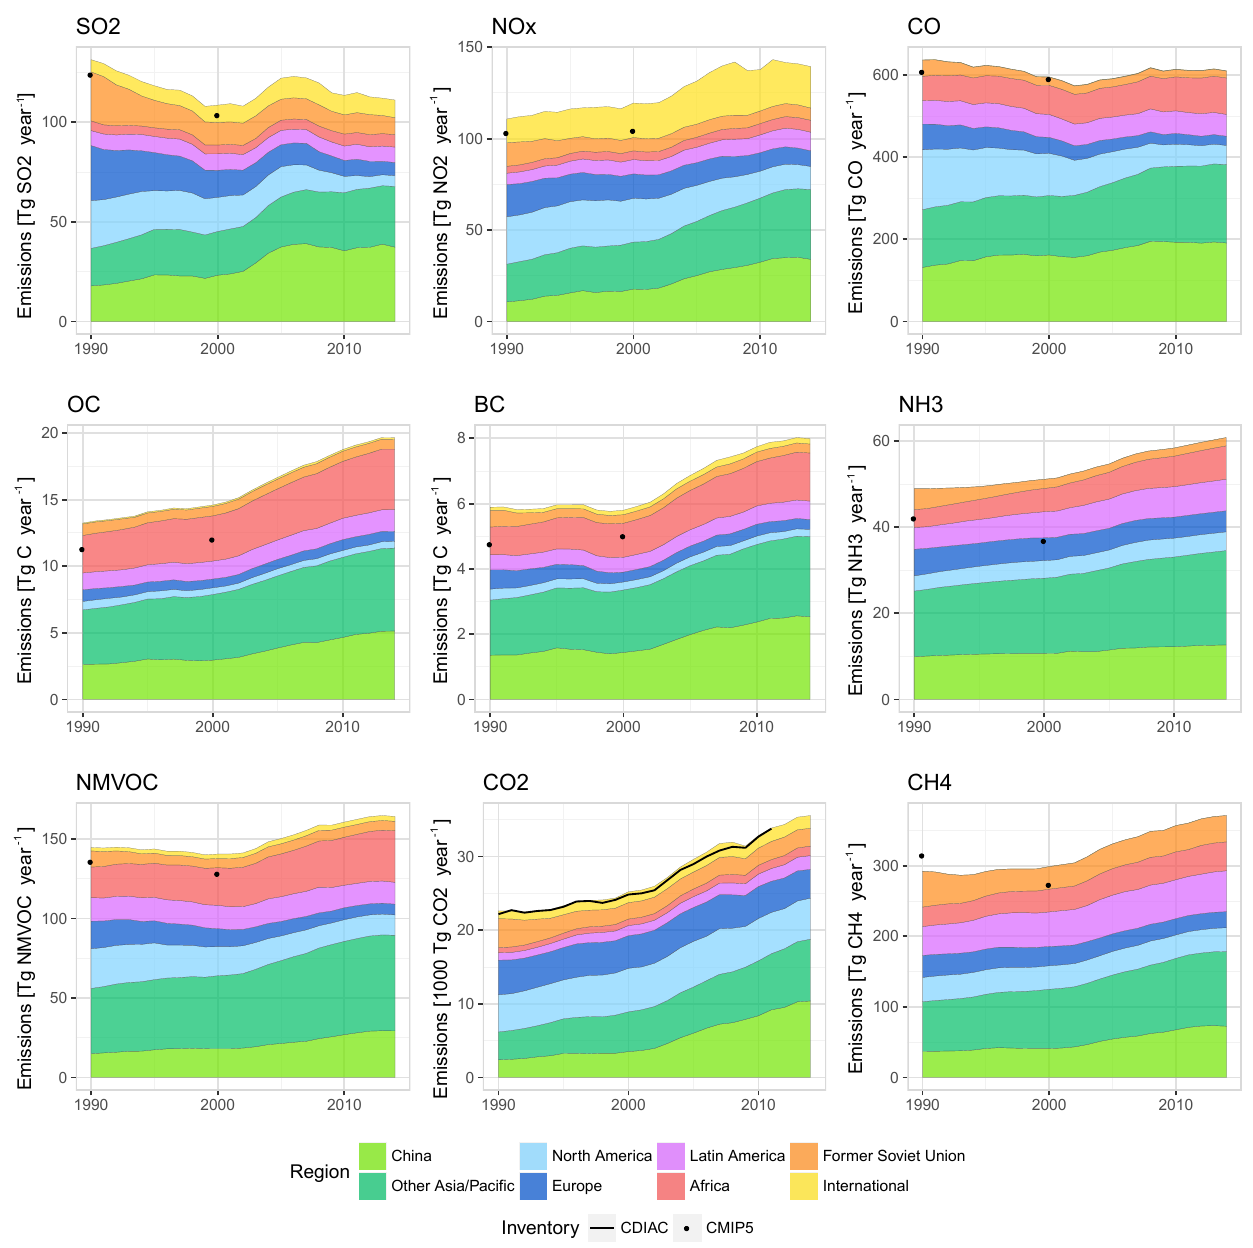
Figure 5. Recent emission estimates (1990–2014) by region compared to Lamarque et al. (2010) (dots) and CDIAC (line) for CO 2 . This shows the same data as Fig. 3 over a shorter timescale. For like-with-like comparison, these figures do not include aviation or agricultural waste burning on fields. The “International” region shows international shipping